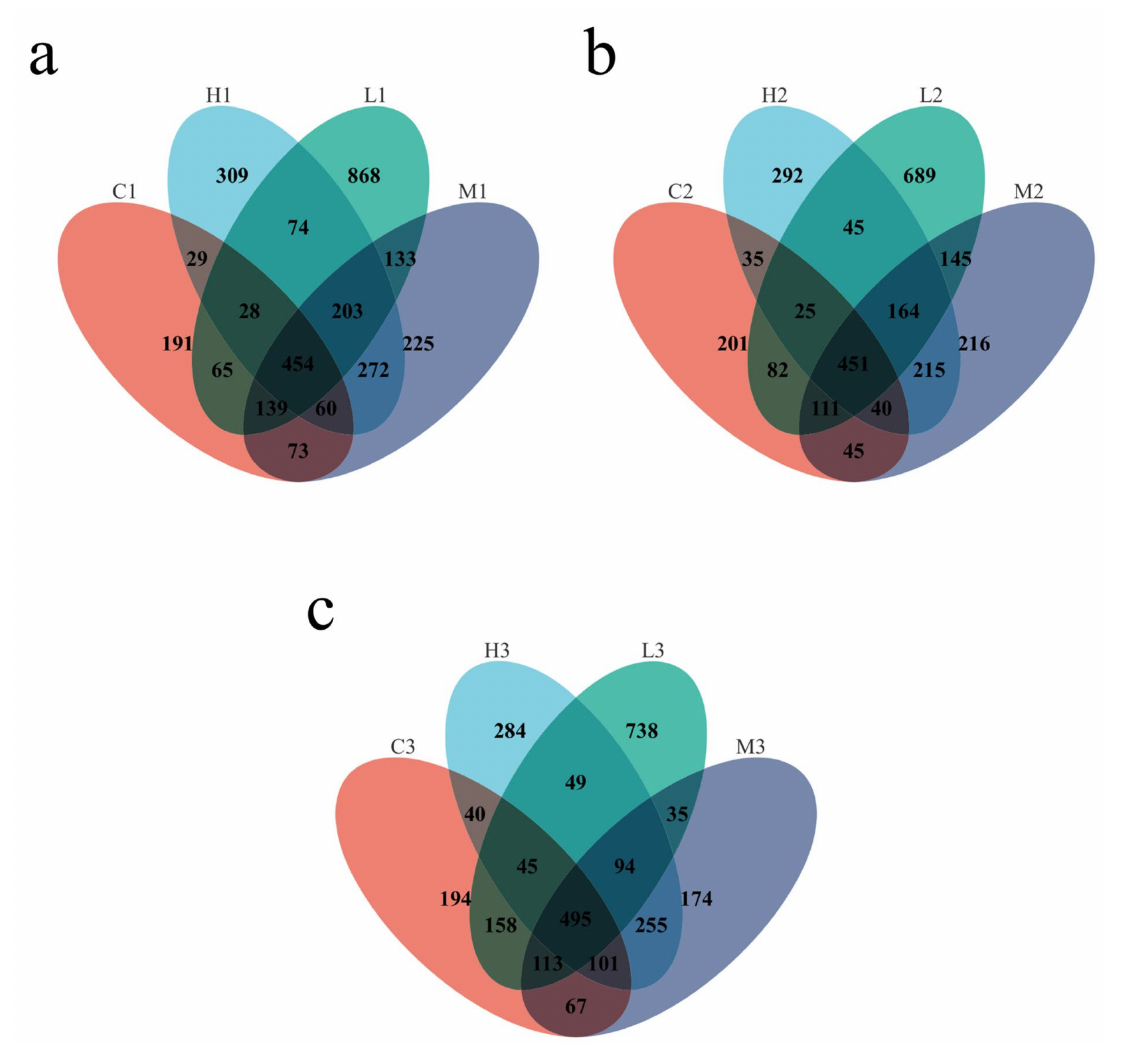
Figure 4. ( a ) Venn diagram between groups at 20 days; ( b ) Venn diagram between groups at 40 days; ( c ) Venn diagram between groups at 60